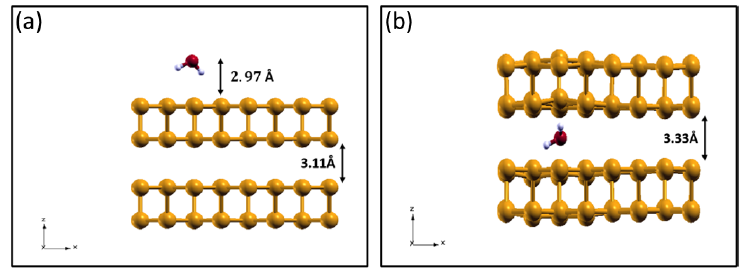
Figure 6. Side view of water adsorbed (Panel ( a )) above and (Panel ( b )) intercalated within the phosphorene